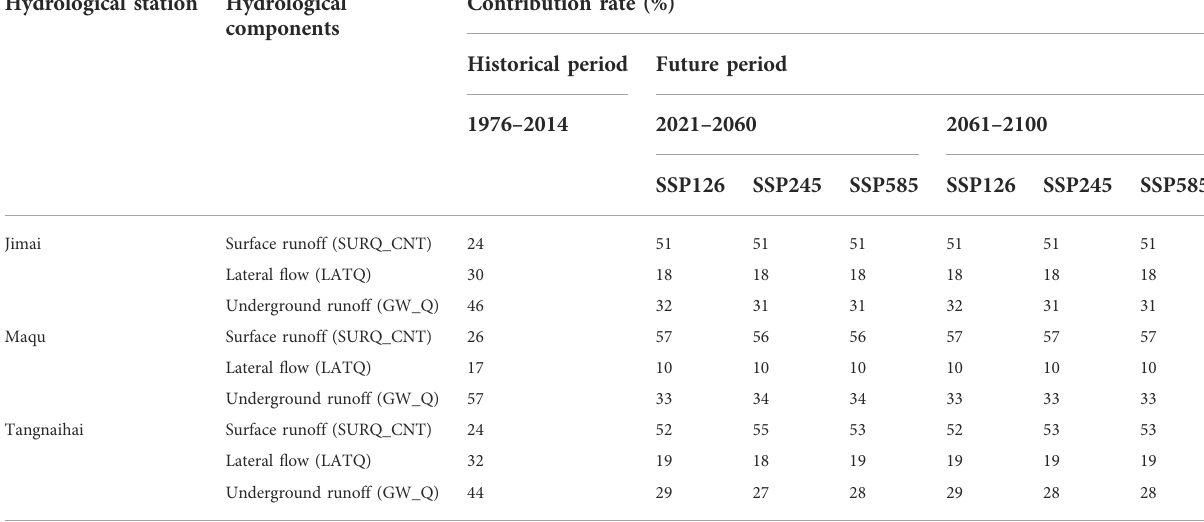
TABLE 8 Contribution rates to total river runoff of hydrological components in three hydrological stations during historical and future periods. Hydrological